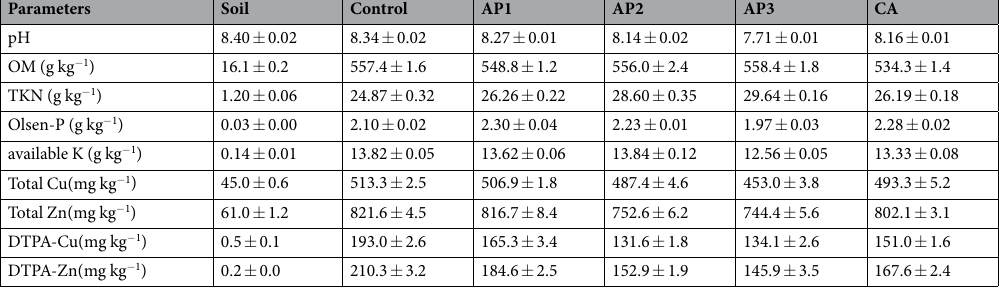
Table 3. Initial properties of soil and matured compost. Note: Values indicate mean ± standard deviation based on the samples with four